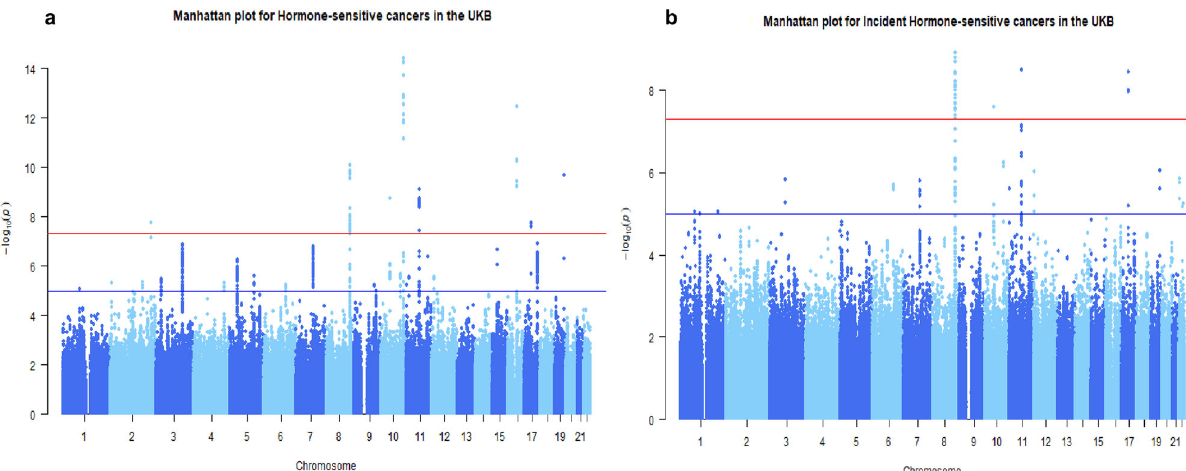
Fig. 2 Manhattan plot for the GWAS analysis of the combined hormone-sensitive cancers in the UKB. The plot shows on the Y-axis the negative log- base-10 of the P value for each of the SNPs positioned along the X axis in genomic order by chromosomal position. The red line shows the threshold for genome-wide signi fi cance ( P < 5 × 10 − 8 ). SNPs with the lowest P value of signi fi cance (i.e., highest association with hormone-sensitive cancer) are positioned at the top of the graph. a The genome wide signi fi cant SNPs for all cases of hormonal cancers [incident and prevalent cases included]. b The panel is for incident cancer cases only. The list of genetic markers for each analysis is attached in the supplementary fi les (Supplementary Tables 7 and 8). The genomic in fl ation factor ( λ ) was rescaled for an equivalent study of 1000 cases/1000 controls ( λ 1000 (all cases) = 1.003 and λ 1000 (incident cases) =